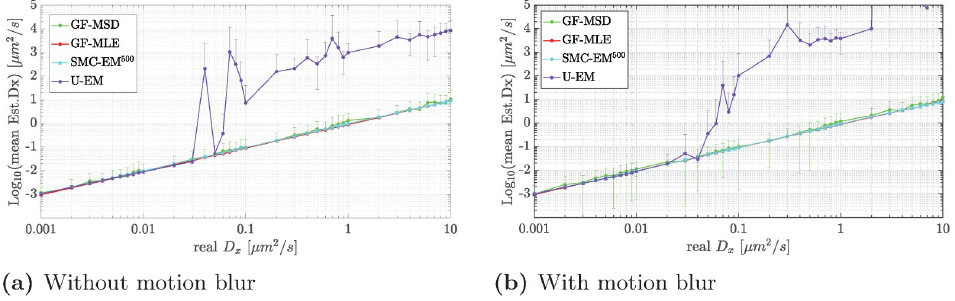
Fig 12. Mean estimates of D by GF-MSD, GF-MLE, SMC-EM, and U-EM as a function of the true diffusion x coefficient. (a) without and (b) with motion blur.